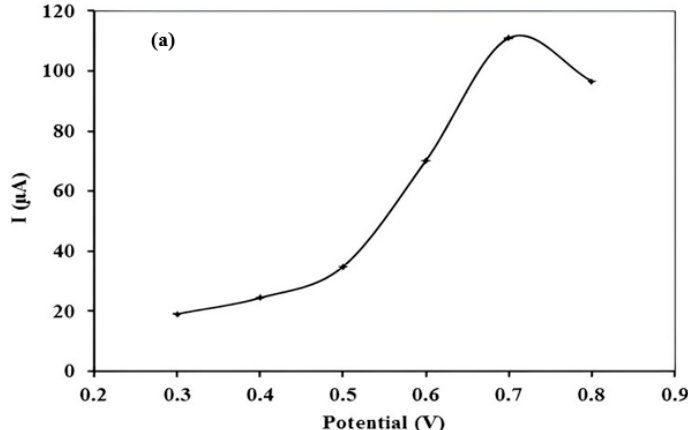
Table 1. Effect of different stripping electrolytes (0.1 M concentration) on peak current intensity for 10 µg L − 1 Hg (II) solution at a deposition potential of − 0.7 V and 12 min accumulation